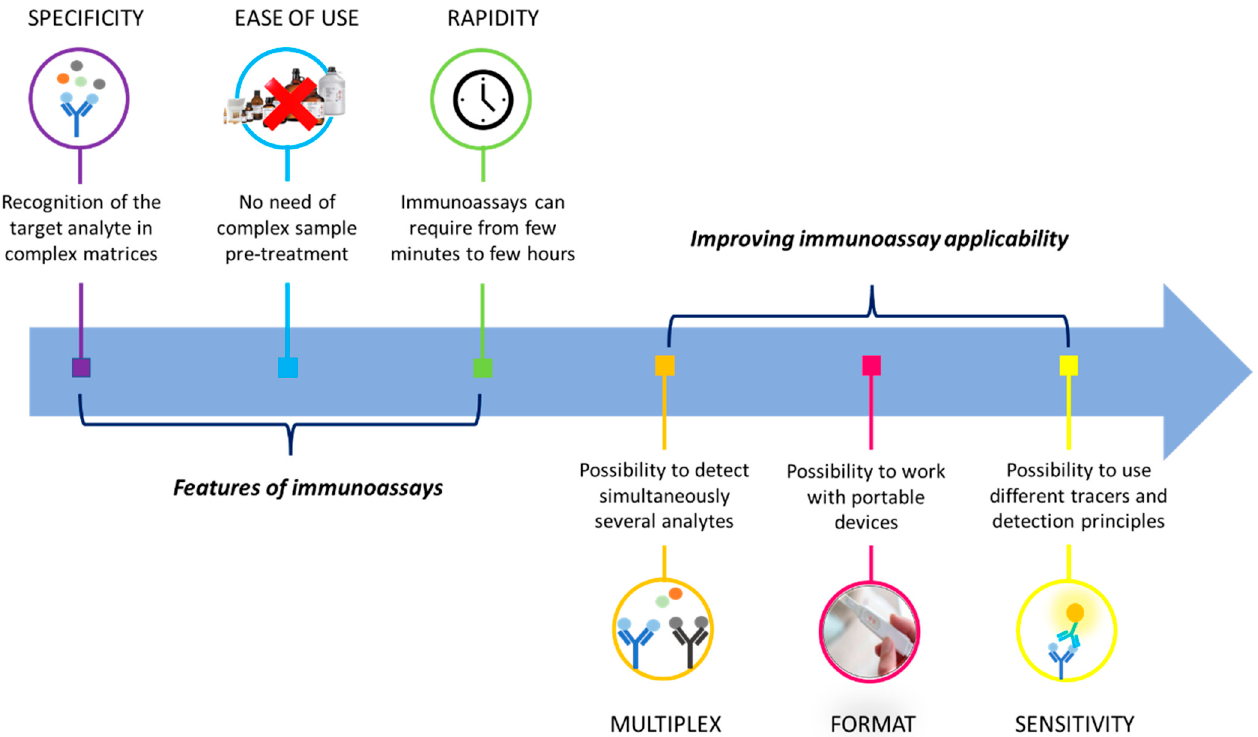
Figure 2. Scheme of the major peculiarities of immunoassays and the key points on which researchers act to improve their performance and implement their applicability.